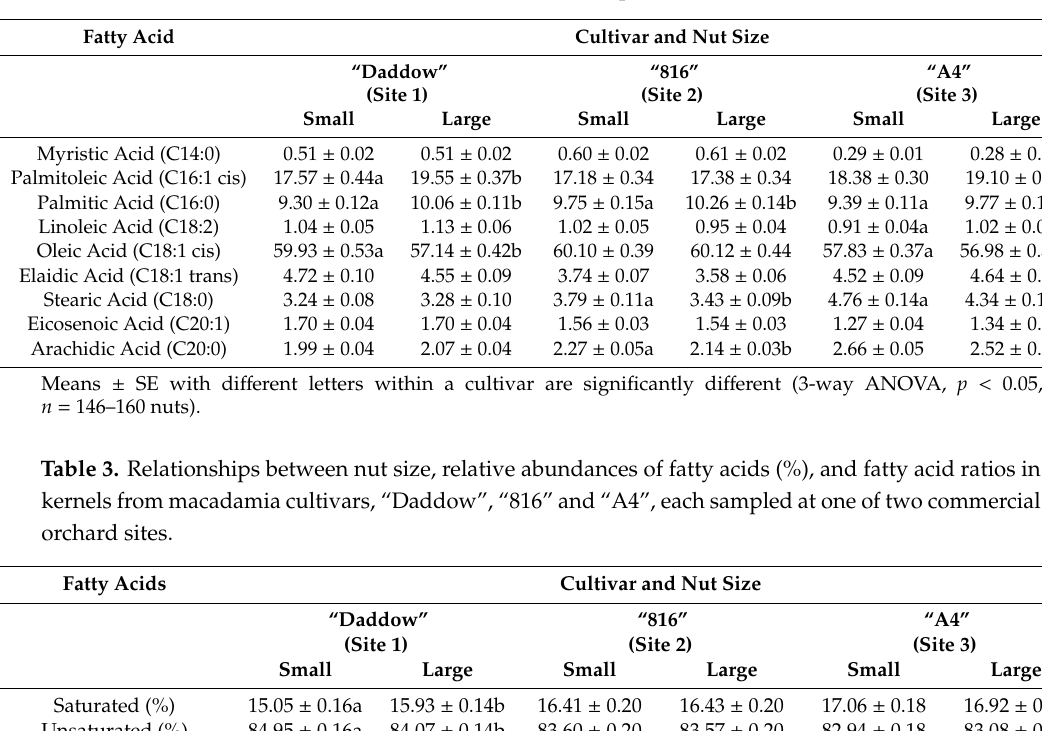
Table 2. Relationships between nut size and relative abundances (%) of fatty acids in kernels from macadamia cultivars, “Daddow”, “816” and “A4”, each sampled at one of two commercial orchard sites.